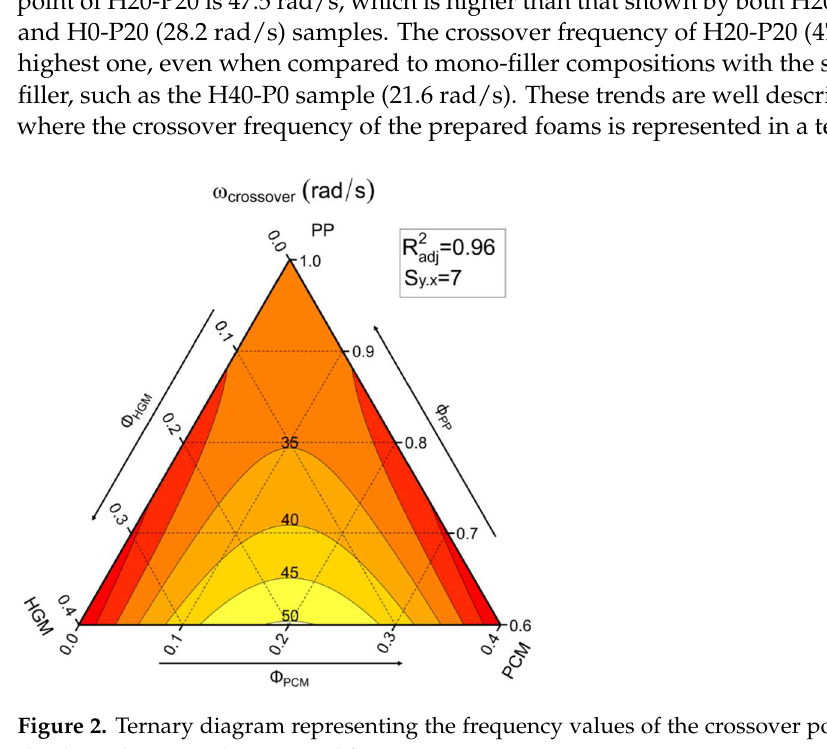
Figure 3. Viscosity ( η ) as a function of the shear rate ( prepared foams.